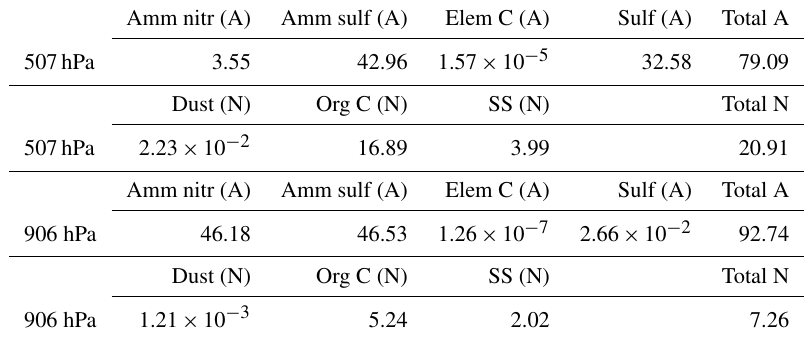
Table 2. Percentage contribution of each aerosol species to total CCN number concentrations at 0.5ms − 1 for 507 and 906hPa. Each aerosol species is indicated as either anthropogenic (A) or natural (N).